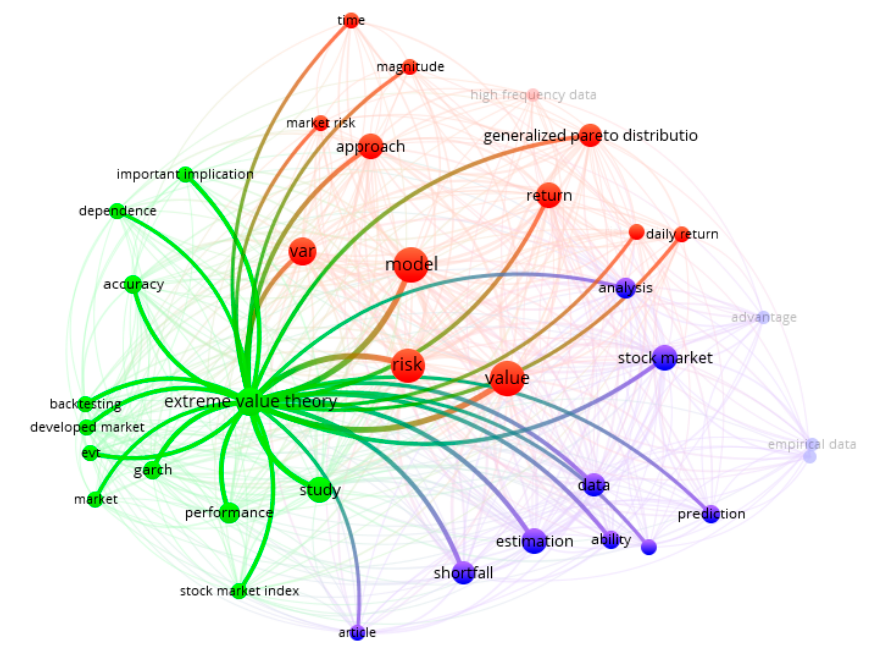
Figure 4. Visualization of linkages between extreme value theory items.